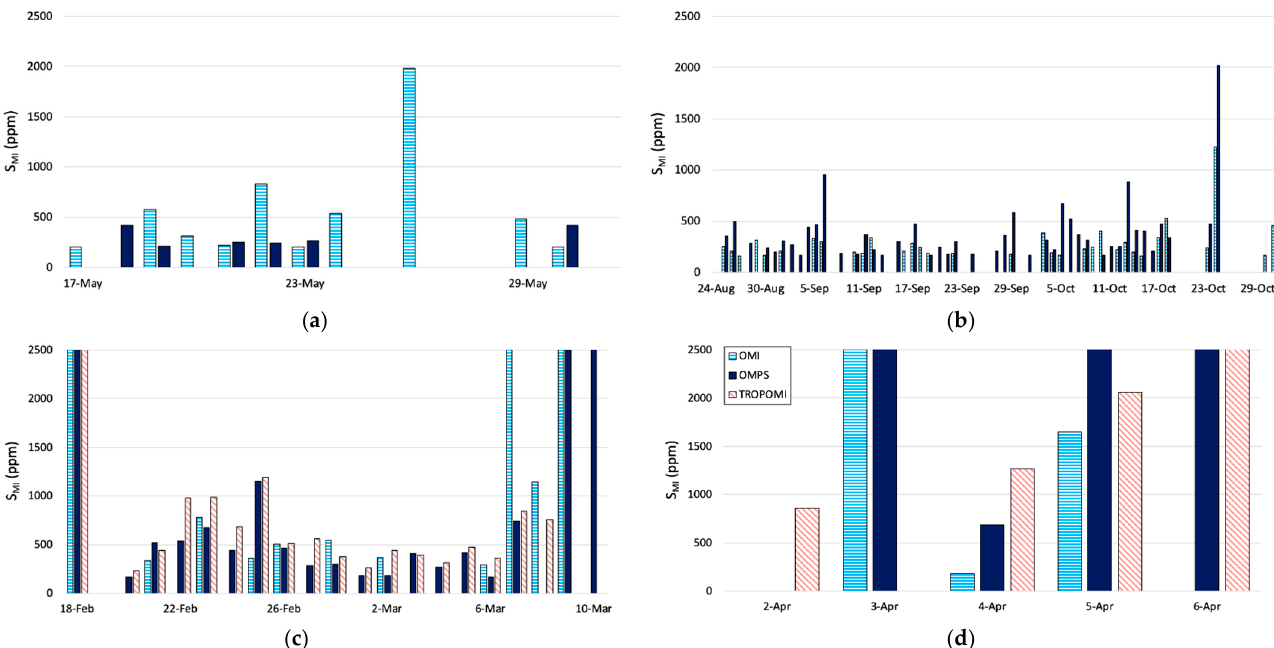
Figure 9. ( a – d ) Daily estimation of the pre-eruptive magmatic sulfur content at Piton de la Fournaise using a reverse petrological approach and fixing the undegassed c matrix at 160 ppm, for eruptions in 2015–2020. The uncertainty of 45% related to these results are not shown on this figure. ( a ) May 2015; ( b ) August–October 2015; ( c ) February 2019; ( d ) April